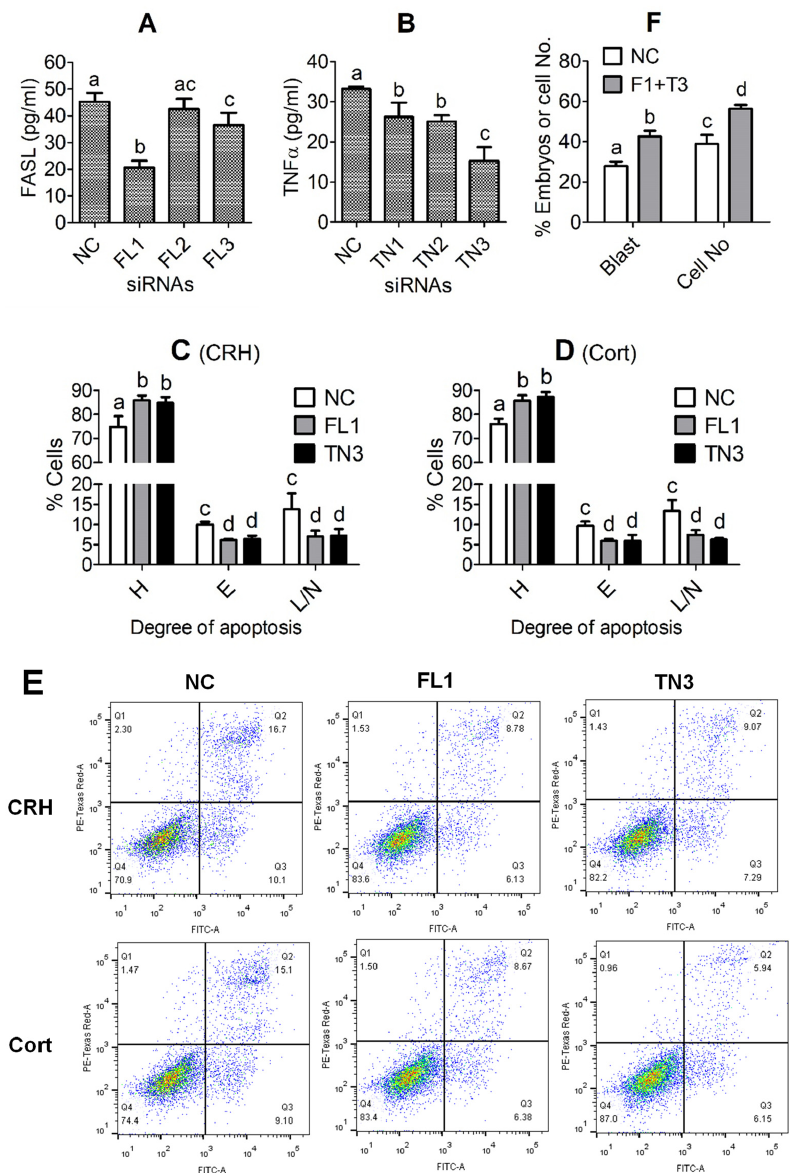
Figure 6. Effects of knocking down Fas ligand ( FASL ) or tumor necrosis factor ( TNF α ) on corticotrophin-releasing hormone (CRH)- or cortisol (Cort)-induced apoptosis of oviduct epithelial cells (OECs). Graphs ( A , B ) show FASL and TNF α concentration, respectively, in CM conditioned for 48 h without hormones with OECs transfected with negative control (NC), FASL siRNA-1 (FL1), -2 (FL2) or -3 (FL3), or with TNF α siRNA-1 (TN1), -2 (TN2) or -3 (TN3). Graphs ( C , D ) show the percentages of healthy (H), early apoptotic (E) or late apoptotic and necrotic (L/N) cells as revealed by flow cytometry following OECs transfected with NC, FL1 or TN3 siRNAs were cultured for 48 h in the presence of CRH and Cort, respectively. Panel ( E ) shows the flow cytometry graphs after the OECs transfected with NC, FL1 or TN3 siRNAs were cultured with CRH or Cort for 48 h. The healthy, early apoptotic and late apoptotic/necrotic cells are located in the Q4, Q3 and Q2 areas, respectively. The Q1 area contains mechanically damaged cell debris. Graph ( F ) shows the percentages of blastocysts (Blast) and cell number per blastocyst (Cell No) following embryo culture in CM conditioned in the presence of both 1 × 10 − 8 M CRH and 4 × 10 − 7 M cortisol with OECs that had been transfected with NC siRNA or co-transfected with both FASL siRNA-1 and TNF α siRNA-3 (F1 + T3). a–d: Values with a different letter above the bars differ significantly ( p <